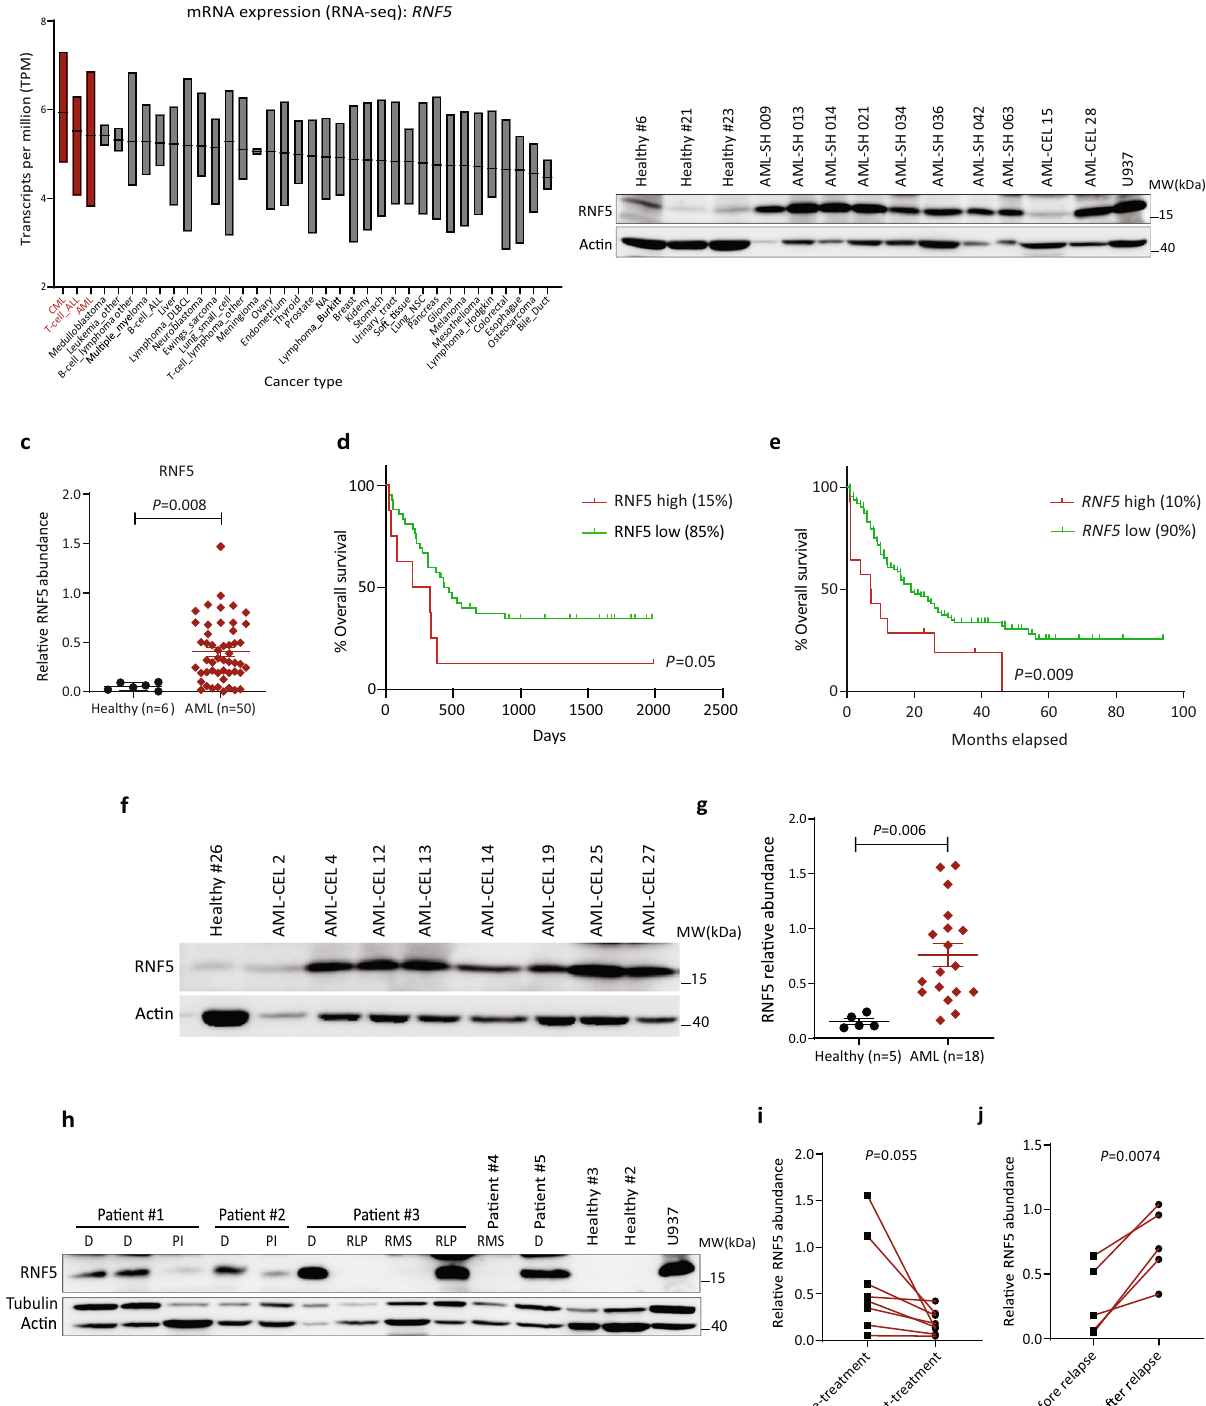
showed reduced colony formation in soft agar relative to controls (Fig. 2d) and increased abundance of proteins associated with apoptosis, as re fl ected by levels of cleaved forms of caspase-3 (Fig. 2e) and poly ADP ribose polymerase (PARP) (Supplemen- tary Fig. 2d). Effects of RNF5-KD on U937 and MOLM-13 cells were con fi rmed in two additional AML cell lines HL-60 and THP-1 (Supplementary Fig. 2e – h). Importantly, re-expression of NATURE COMMUNICATIONS| (2021) 12:5397